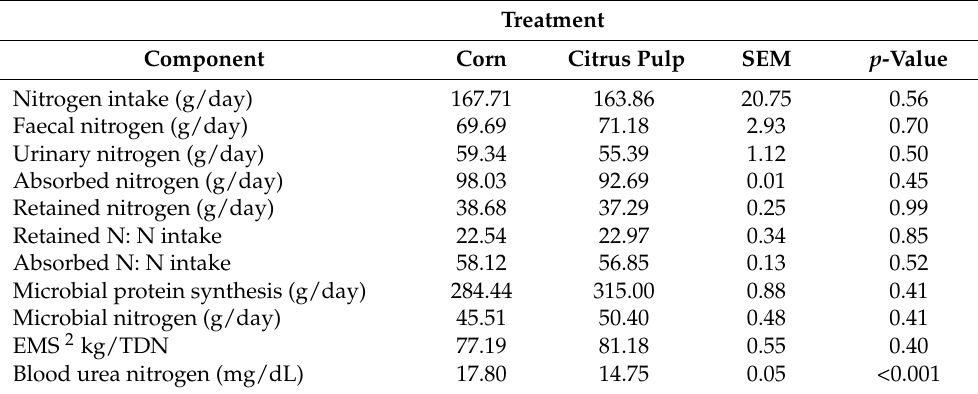
Table 4. Nitrogen balance, efficiency of microbial synthesis and blood urea nitrogen of rumen- cannulated Nellore steers grazing Uruchloa brizantha cv Marandu pastures and fed corn or citrus pulp-based supplements during the wet-dry transition period 1 .